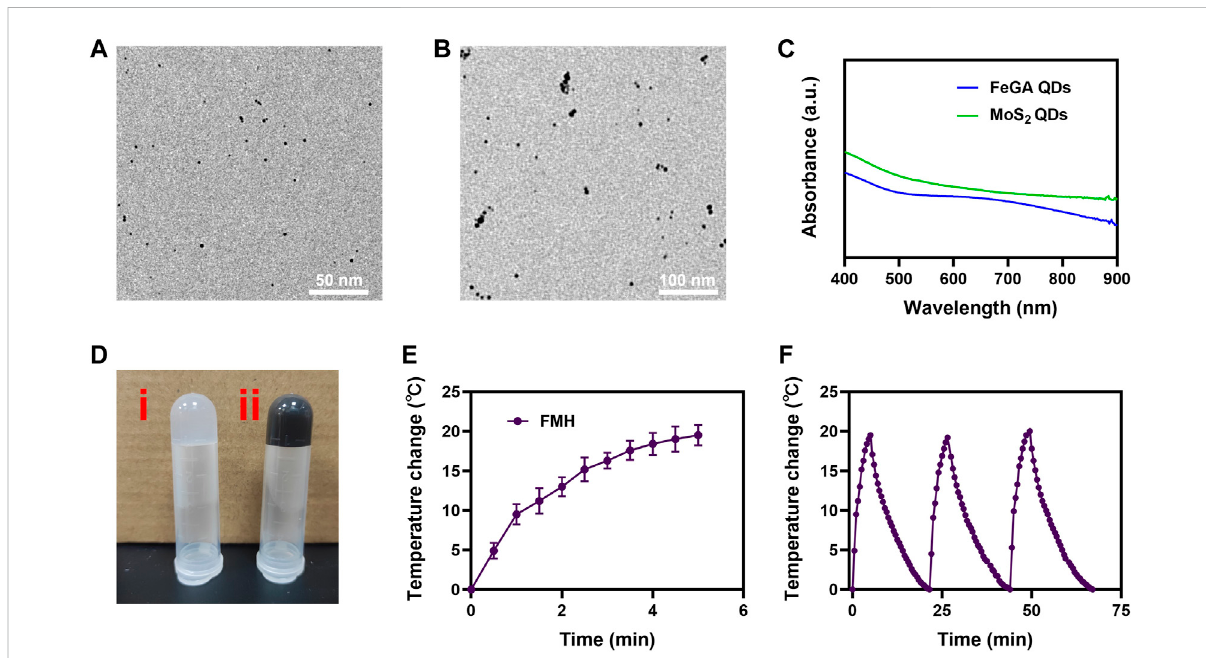
FIGURE 1 (A) TEM image of FeGA QDs. (B) TEM image of MoS 2 QDs. (C) UV-vis-NIR spectra of FeGA QDs and MoS 2 QDs. (D) Photographs of (i) pure hydrogel and (ii) FMH. (E) The temperature pro fi le of FMH irradiated by NIR laser (808 nm, 0.5 W/cm2), followed by natural cooling to room temperature. (F) The photothermal stability (three laser on/off cycles) of